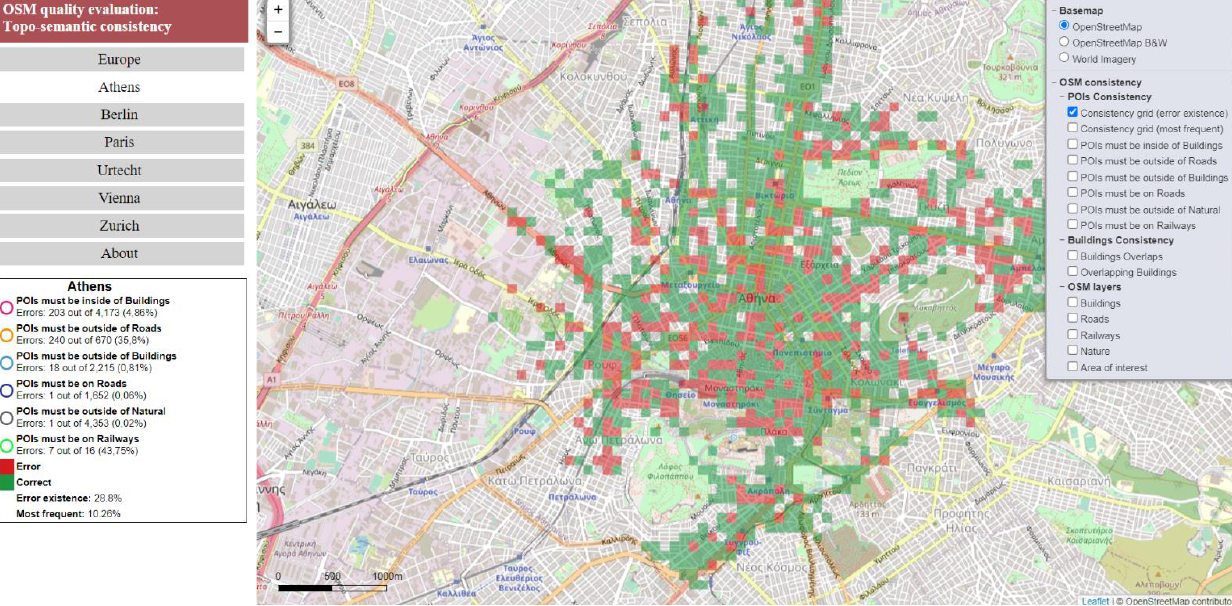
Figure A3. Consistency Grid (error existence) for Athens.